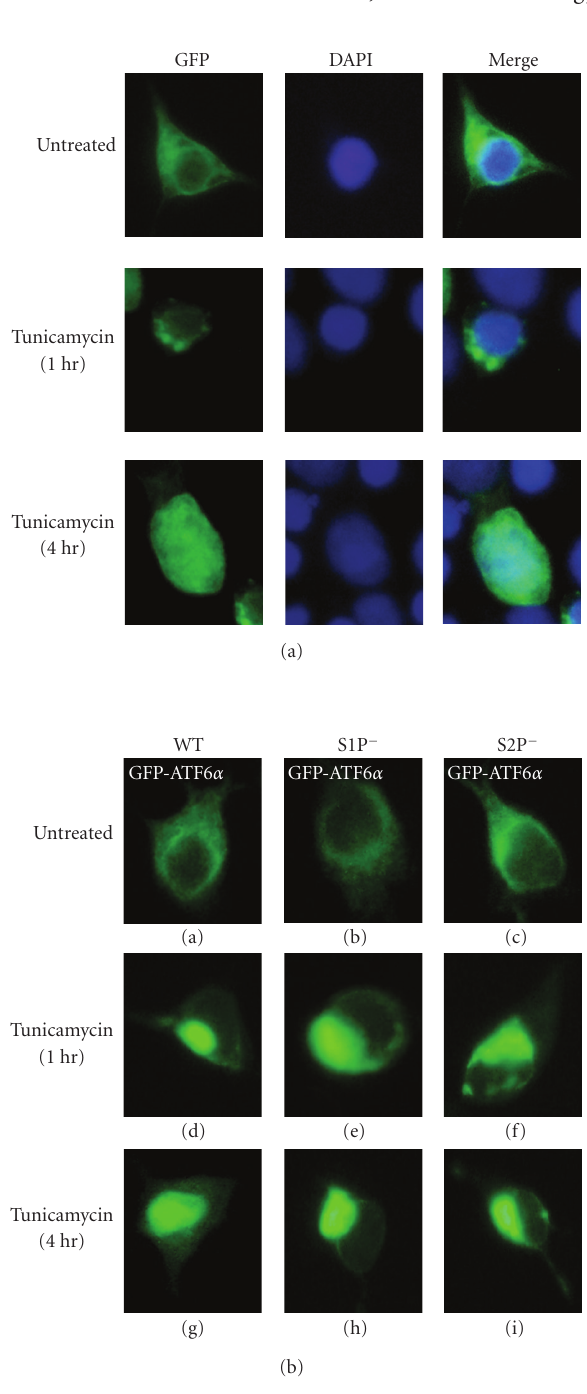
Figure 4: ER stress-induced processing and nuclear translocation of GFP-ATF6. (a) Twenty-four hours after transfection with pCMVshort-EGFP-ATF6 (WT), 293T cells were left untreated or treated with 1 μ g/mL tunicamycin for the indicated periods. Cells were fixed in 4% paraformaldehyde, stained with DAPI, and then analyzed by fluorescence microscopy. (b) Twenty-four hours after transfection with pCMVshort-EGFP-ATF6 α (WT), pCMVshort- EGFP-ATF6 α (S1P − ), or pCMVshort-EGFP-ATF6 α (S2P − ), 293T cells were left untreated or treated with 1 μ g/mL tunicamycin for the indicated periods and then analyzed by fluorescence